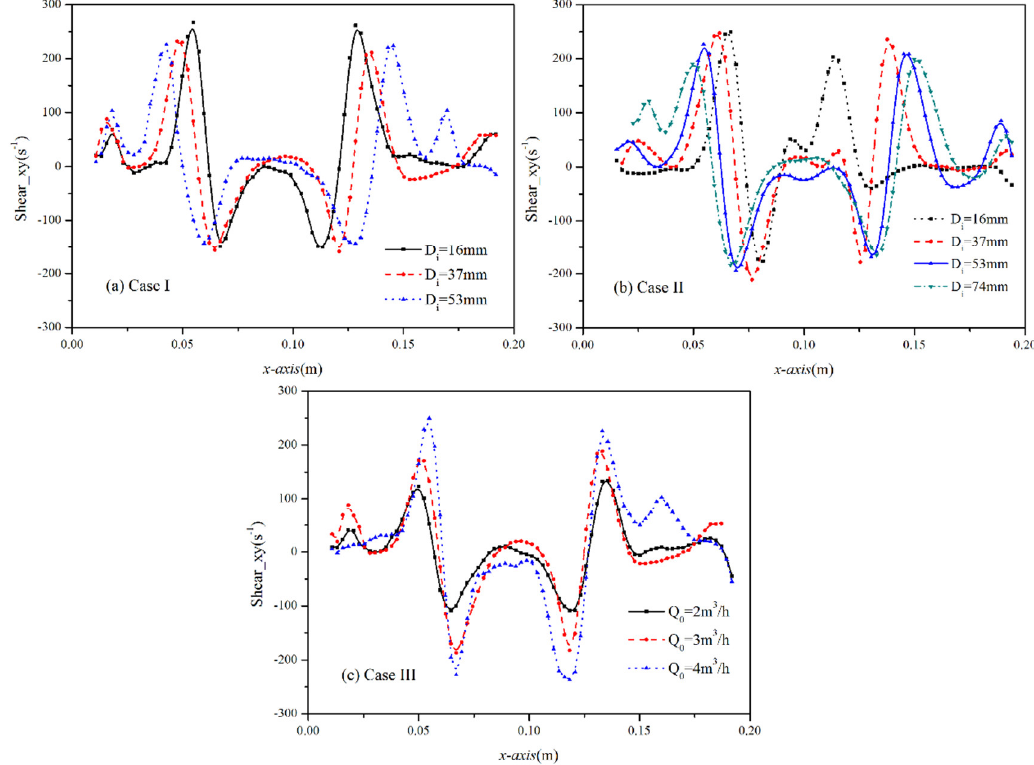
Figure 8. The shear_xy force distribution ( ϵ ) along the centerline under three cases